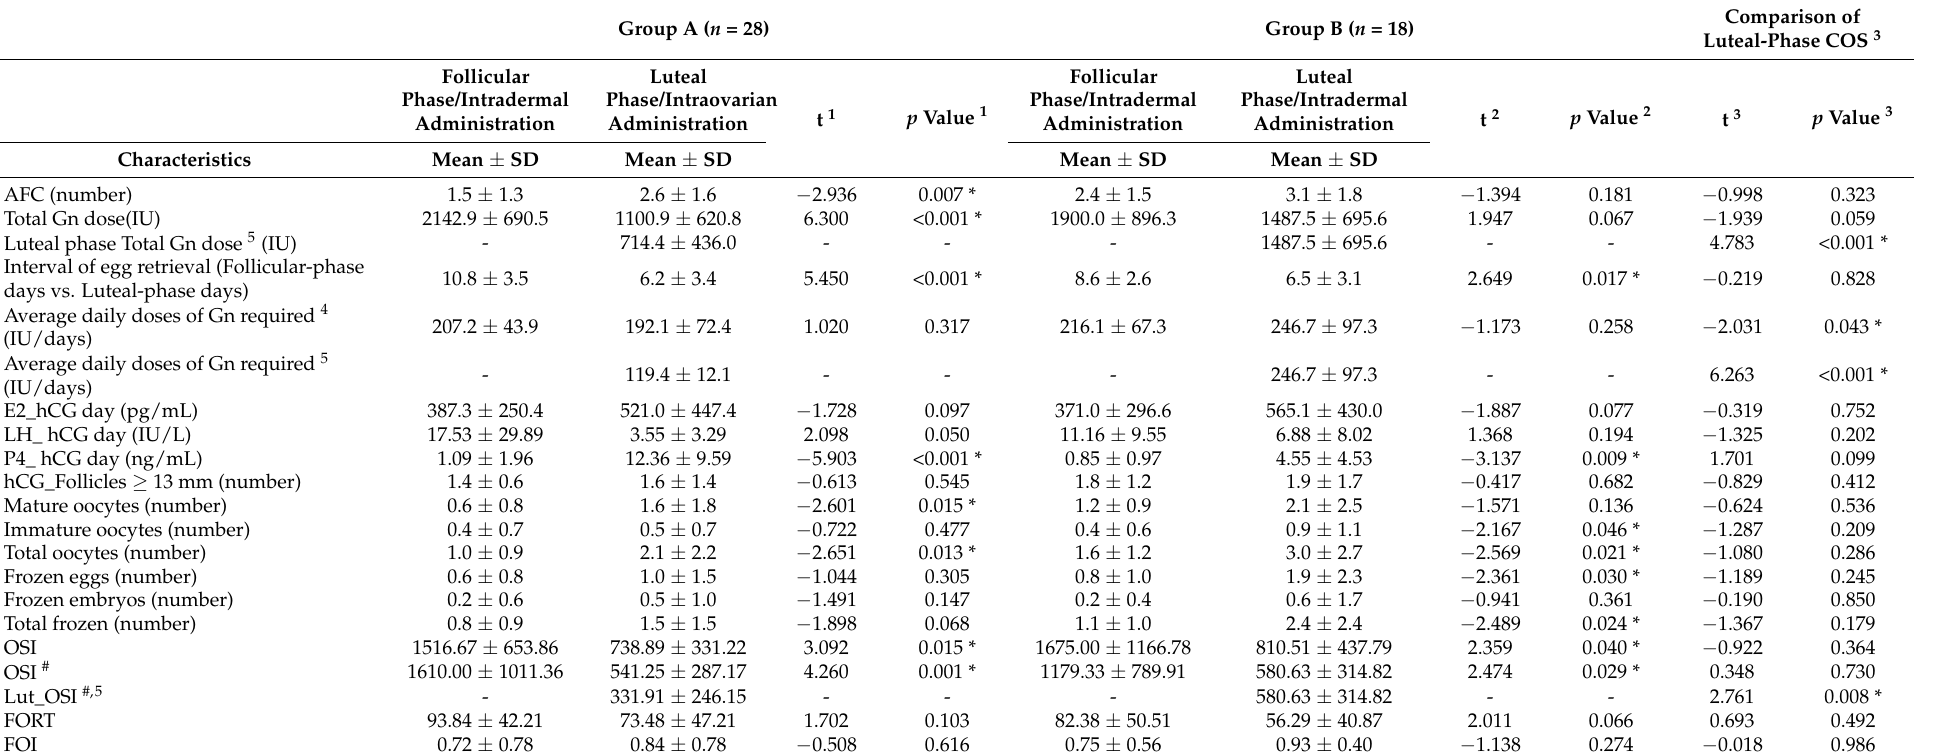
Table 3. Comparison of clinical response between the follicular phase and luteal phase in Group A and Group